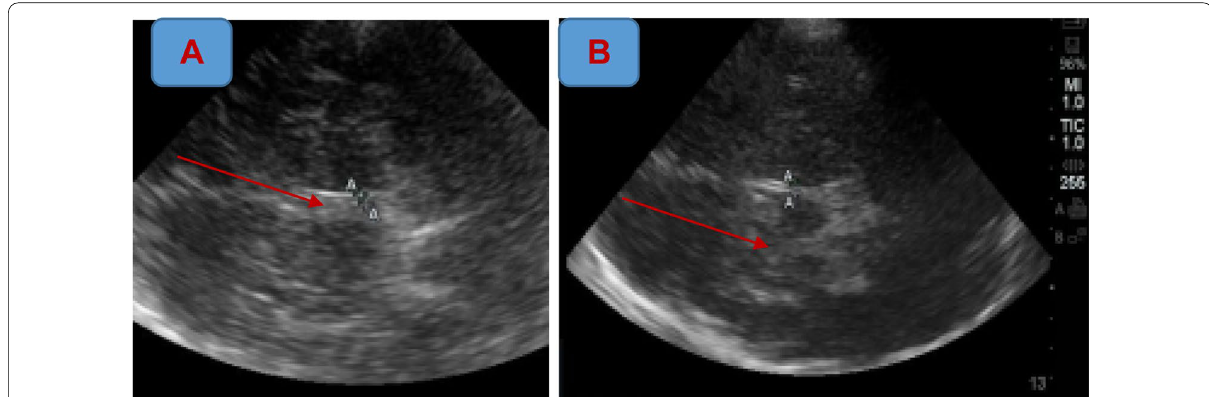
Fig. 4 Abnormal echogenicity of the thalamus and lentiform nucleus. A Increased echogenicity of the thalamus (compared to normal hypo-echo state and similar to occipital horn) (Arrow), B increased echogenicity of the lentiform nucleus (Arrow)